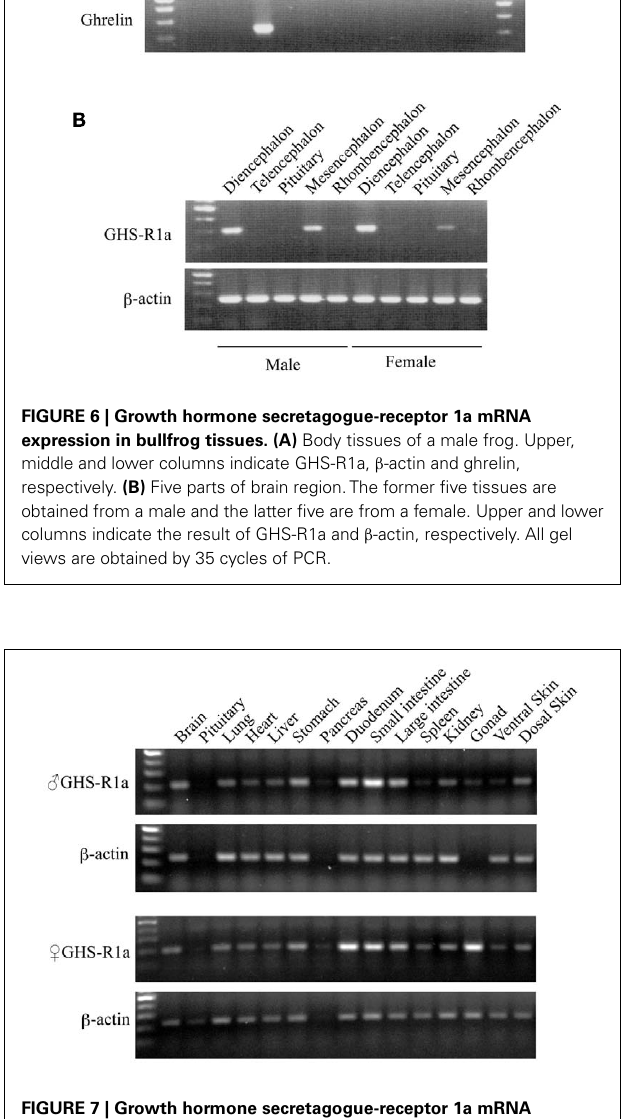
FIGURE 7 | Growth hormone secretagogue-receptor 1a mRNA expression in Japanese tree frog tissues. The gel views represent the result of GHS-R1a (28 cycles PCR) and β -actin (18 cycles PCR), respectively, in body tissues of a male (upper two columns) and a female (lower two columns).